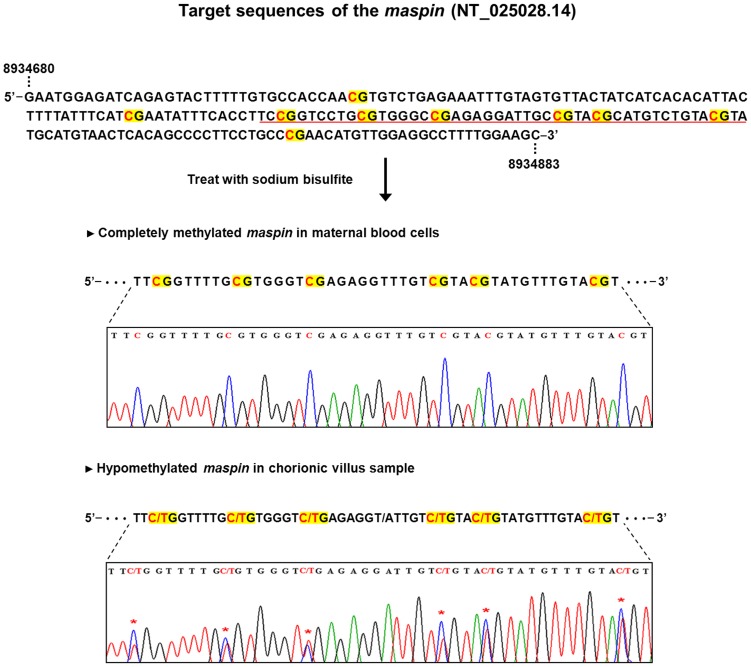
Bisulfite sequencing of the maspin promoter in first trimester paired placental tissue and maternal blood cells.The red characters in the sequences indicate methylation CpG sites of the maspin gene. Unmethylated CpG sites of maspin were detected only in placental tissue. Methylated CpG sites of maspin were detected in placental tissue and maternal blood cells.